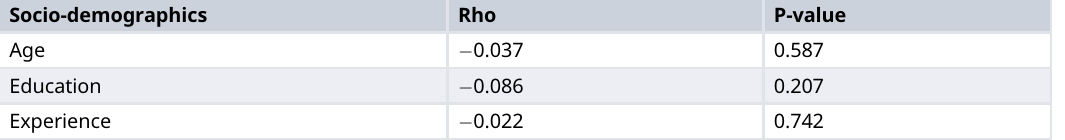
Table 7. Correlation between the attitude and socio-demographics of dental auxiliaries (2021).